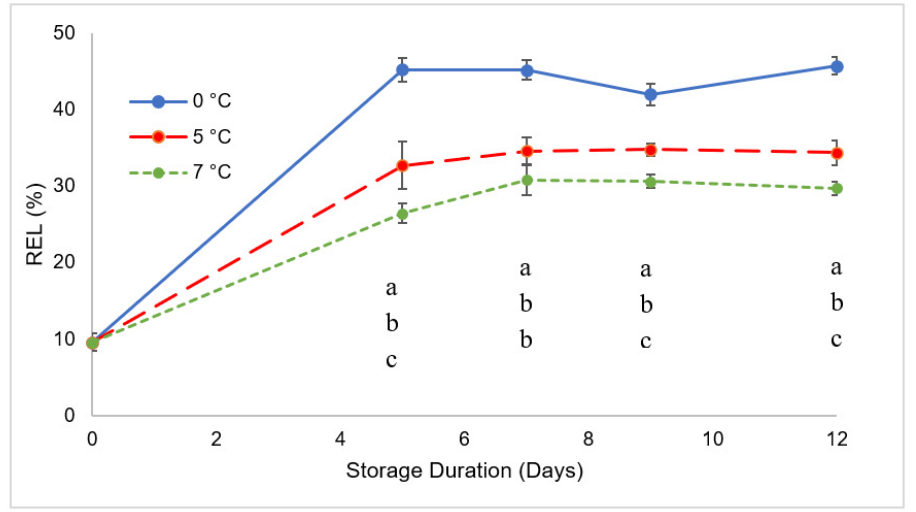
Figure 4. Relative electrolytic leakage of goji berries during storage. Values marked with the same letter on the same harvest day are not significantly different, according to a Tukey’s test ( p < 0.05).